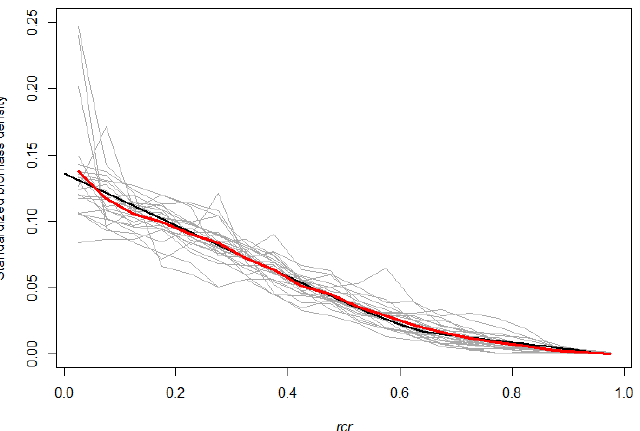
Figure 7. Observed horizontal branch biomass distribution for the 23 destructively sampled beech trees ( grey lines ); the distribution of the average tree obtained using a non-parametric local regression (LOESS) with a smoothing span α = 0.75 ( red line ); and the fitted Max and Burkhart [35] segmented model ( black line ).